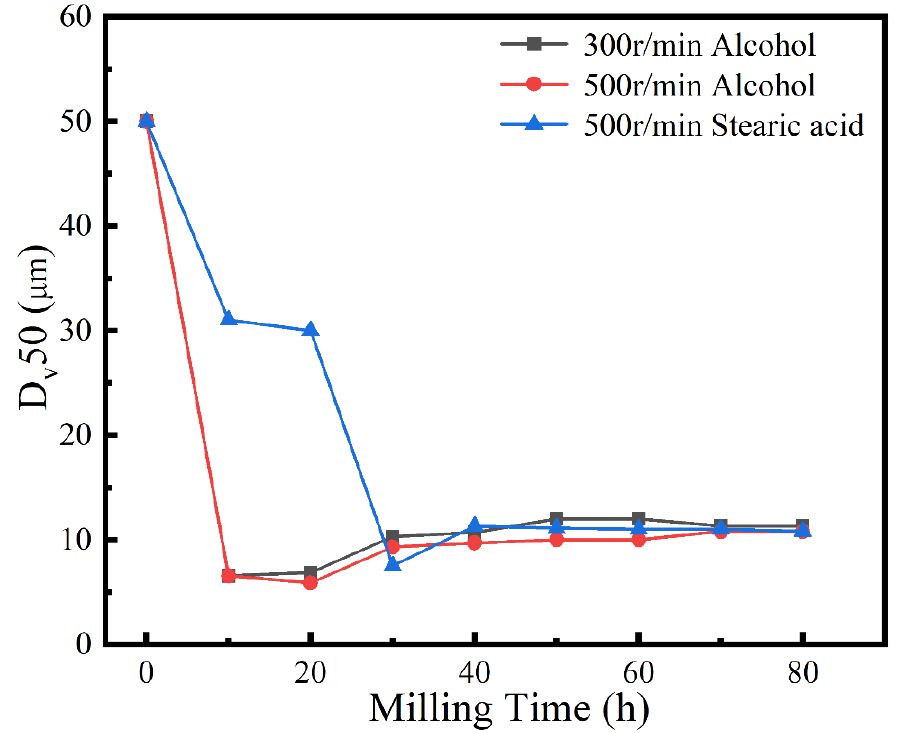
Figure 8. Powder D v 50 under different milling parameters.